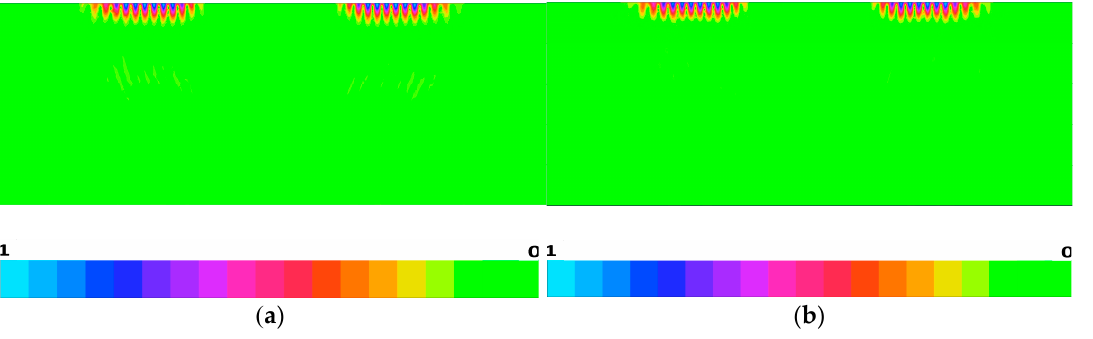
Figure 7. Normalized absolute value of acoustic wave displacement excited by the IDT consisting of five electrode pairs with period λ = 20 μ m and thickness h/ λ = 1%: ( a ) for the Z-cut and the pseudo-surface wave propagation direction along the X-axis, and ( b ) for the Z-cut and the SAW propagation direction along the X + 70°-axis on KTP.